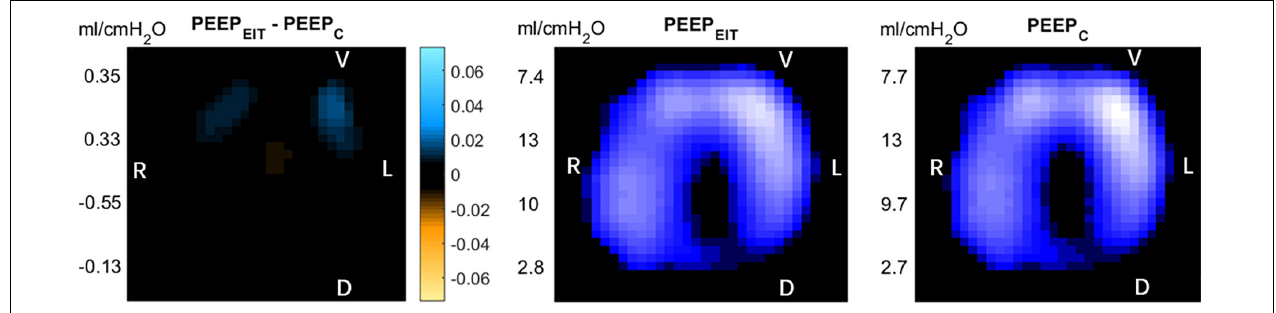
FIGURE 1 | Left: After the positive end-expiratory pressure (PEEP) titration by the two methods, the difference of electrical impedance is displayed on the electrical impedance tomography (EIT) diagram. Blue: compliance gain; Orange: compliance loss. Middle: PEEP titrated according to the regional compliance method. Right: PEEP titrated according to global dynamic respiratory system compliance. R, right; L, left V, Ventral D, dorsal.